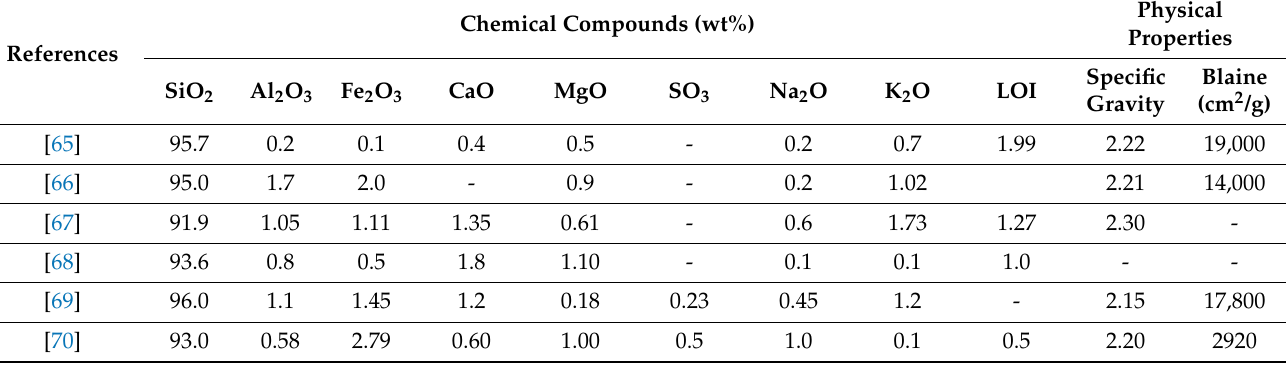
Table 3. Chemical composition of silica